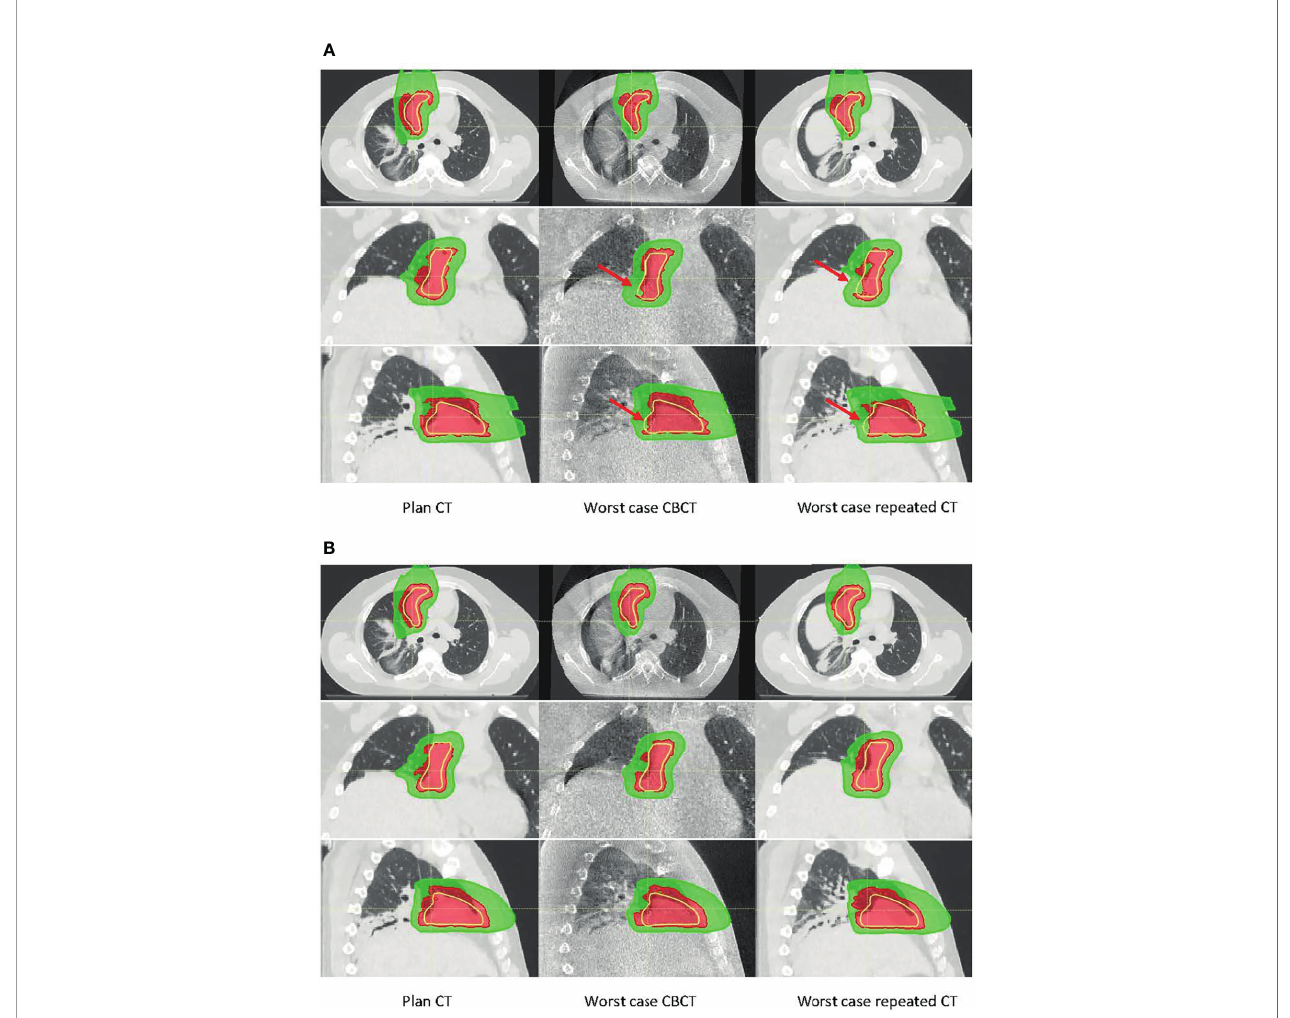
FIGURE 9 | Dose distribution calculated on planning CT (left), worst-case cone-beam CT (CBCT) (middle), and worst-case repeated CT (right) for (A) the single breath-hold BH CT plan and (B) multiple BH CT plan. There were ~8-mm superior – inferior (SI) BH uncertainties between the planning CT and the worst-case CBCT or CT. Red arrows in panel A point to the area where target coverage was